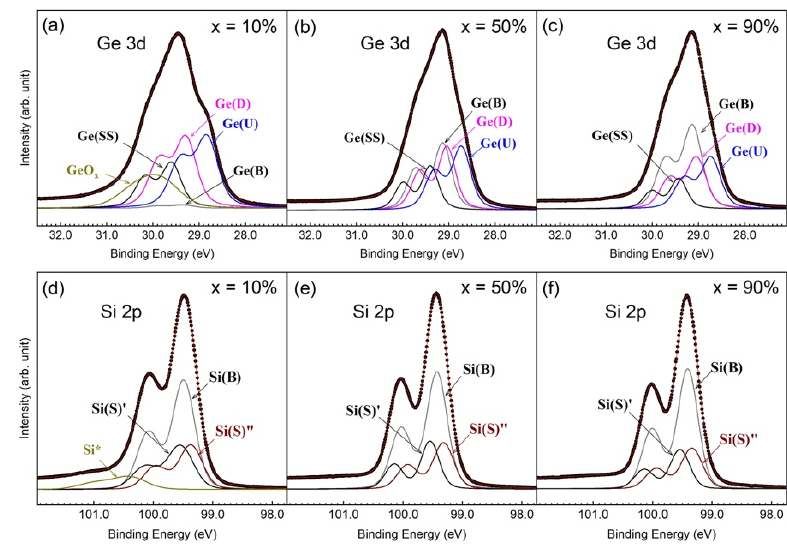
Figure 9. Fitting for the Ge 3d ( a – c ) and Si 2p ( d – f ) core-level spectra. Table 3. Fitted parameters of the Ge 3d core-level spectra in Figure 9.